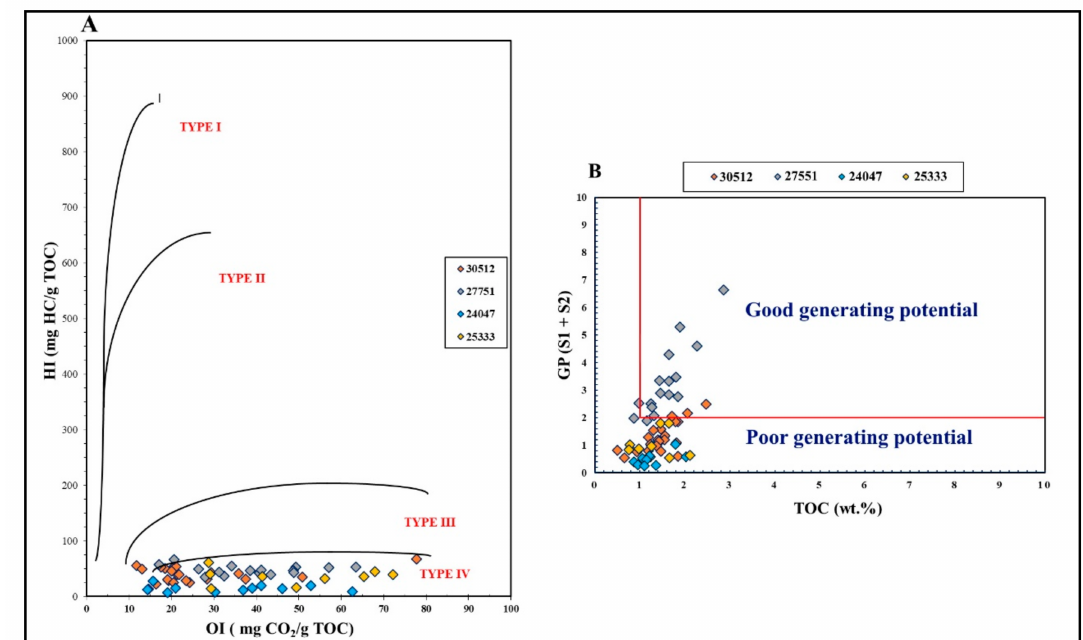
Figure 4. ( A ) pseudo van Krevelen plot illustrating the kerogen type. ( B ) Cross plot of TOC vs. GP demonistrating the generating potential of the tested